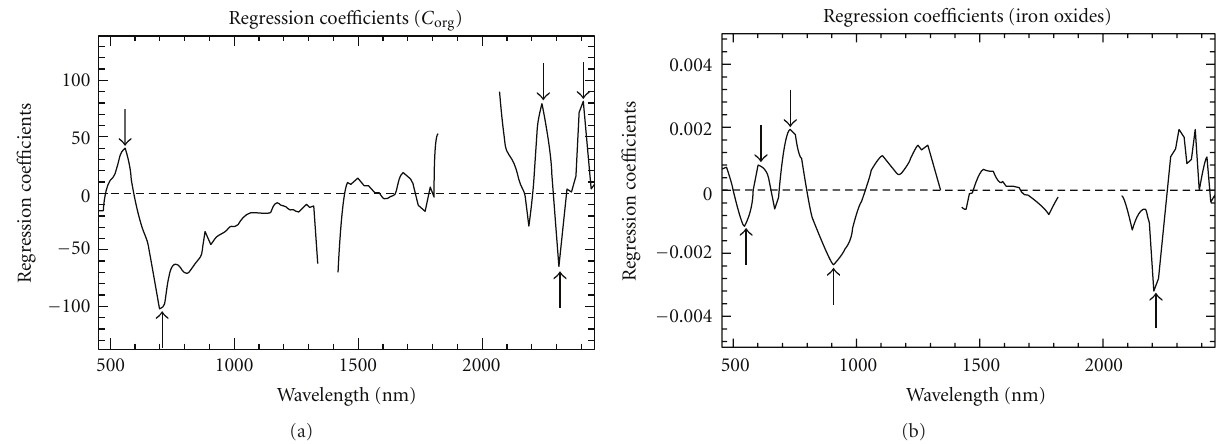
Figure 7: Regression coe ffi cients of PLS models for the prediction of soil organic carbon (a) and iron oxides (b) built upon bare soil field spectra in HyMap’s spectral resolution of 116 bands. Shape and range of spectral regression coe ffi cients are related to the selected data pretreatment method (A: log(1 /R ) + first derivative, B: Mean